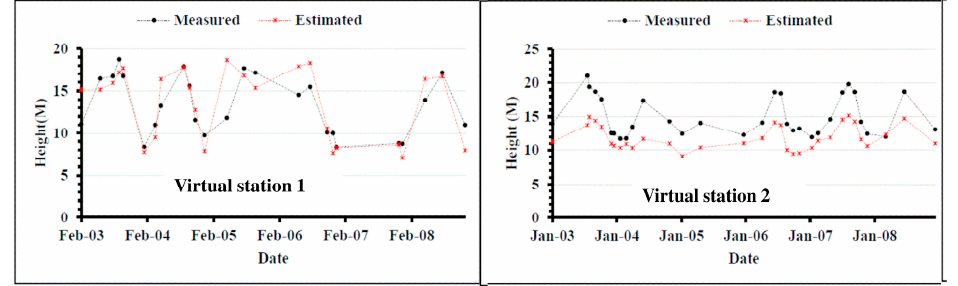
Figure 12. Comparison of the estimated river depth at the virtual stations (red) and the computed depth using the river cross-section measurement at the ground station (black).